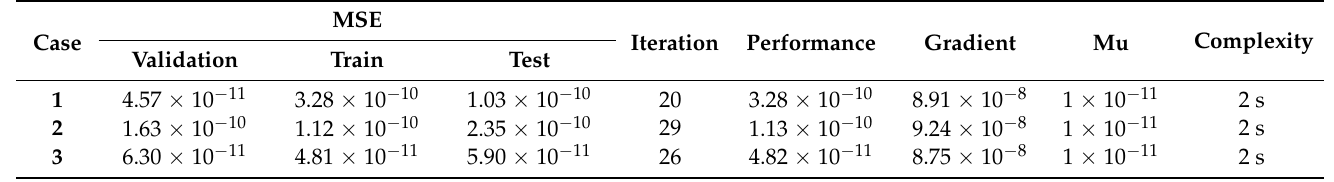
Figure 4. Output assessments and EHs to solve the fractional monkeypox infection mathematical model. Table 2. Stochastic procedures to solve the fractional monkeypox infection mathematical